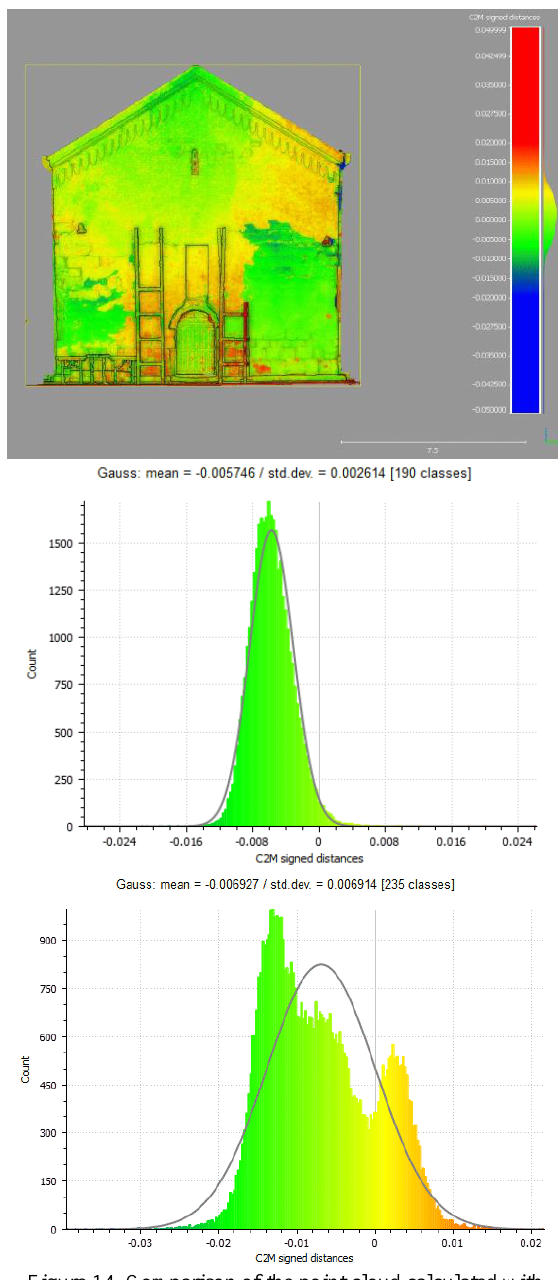
Figure 14. Comparison of the point cloud calculated with RealityCapture (BLK360 and images) compared to